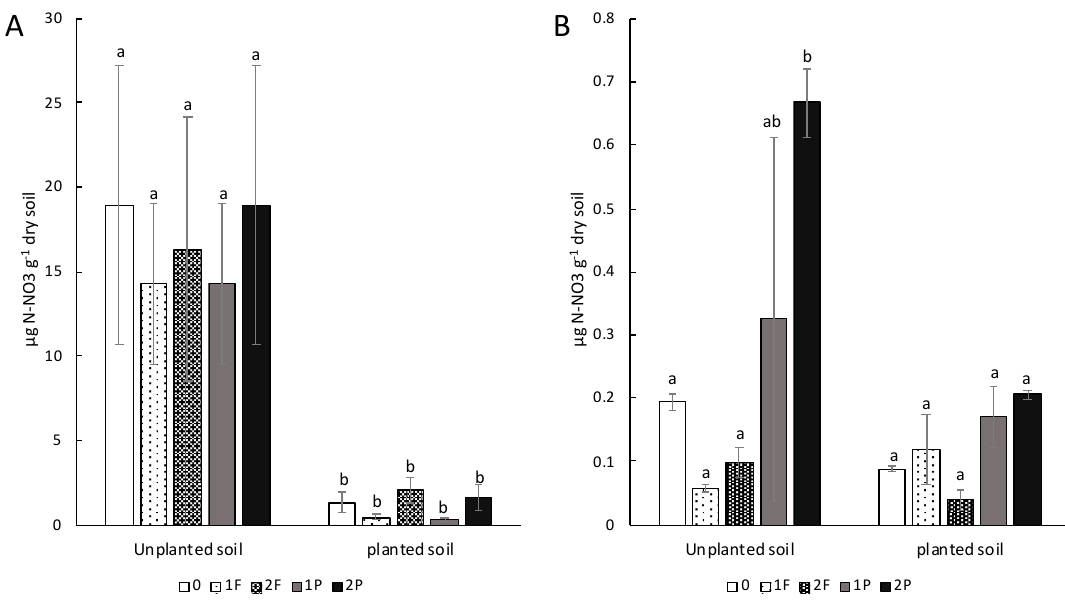
Figure 3. Amendment effects on total and denitrifying bacterial abundance. ( A ) Total bacterial community (copy numbers of 16S ribosomal RNA (rRNA)·g − 1 of dry soil); ( B ) denitrifying bacteria with copy numbers of nirK· g − 1 of dry soil; ( C ) denitrifying bacteria with copy numbers of nirS· g − 1 of dry soil. Unplanted soil, unamended (0), one fertilizer application (1F), two fertilizer applications (2F), one procyanidin application (1P), and two procyanidin applications (2P). n = 3 for each treatment. Vertical bars indicate standard errors. Different letters (a, b and c) indicate which means differed (Nemenyi’s test, α < 0.05).